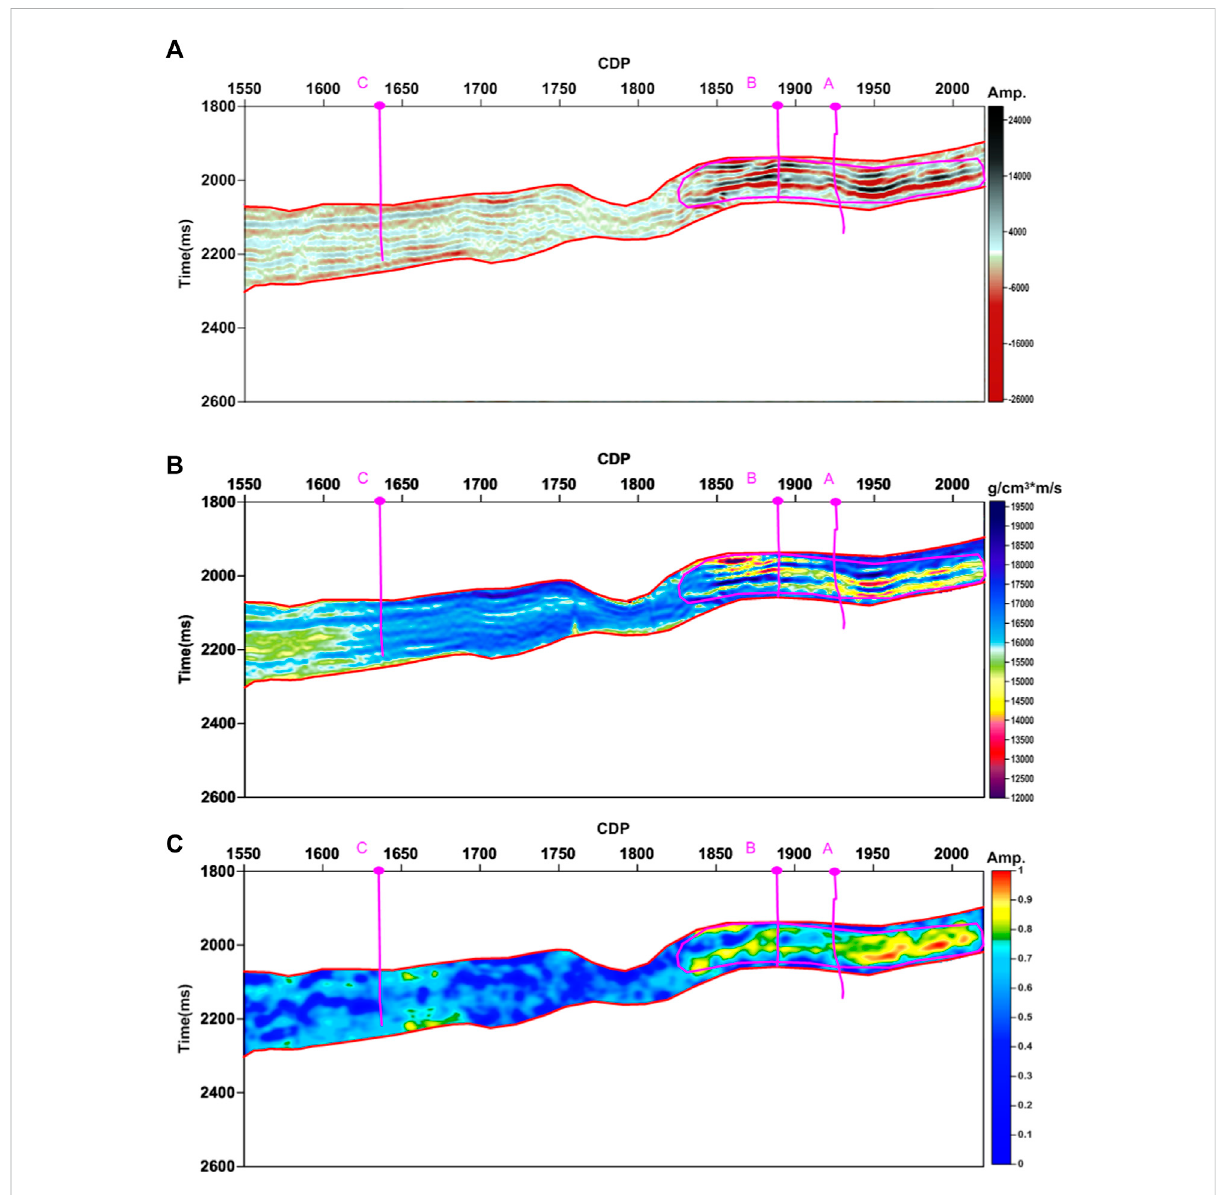
FIGURE 8 Results analysis. (A) The seismic section between the two horizons. (B) Poststack wave impedance inversion section. (C) The absorption gradient section using the proposed method. Only the seismic data between the two horizons are displayed.